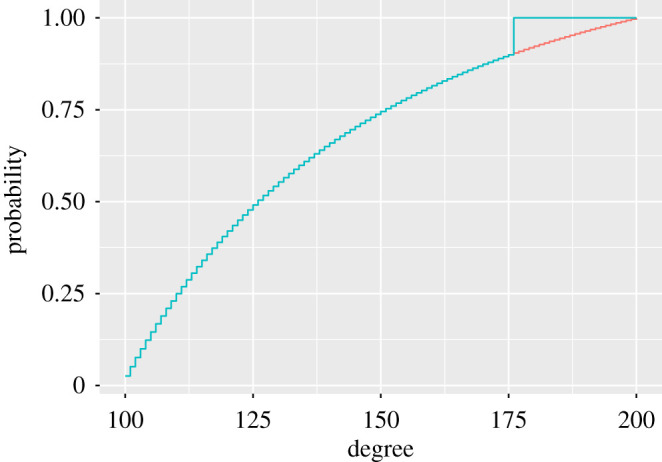
Under H0 degree distribution is the ‘continuous’ (red in online version) conditional de Solla Price power-law, whereas under H1 the degree distribution is taken to be the ’discontinuous’ (blue in online version) function with hc = 0.1 and c = 100. (Online version in colour.)